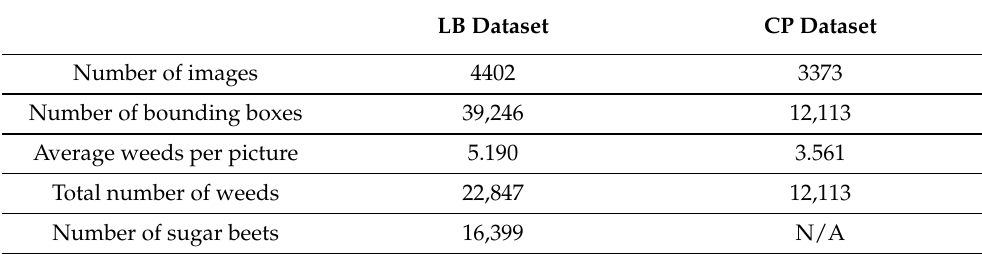
Table 3. Characteristics of the Lincoln Beet (LB) and Chicory Plant (CP)